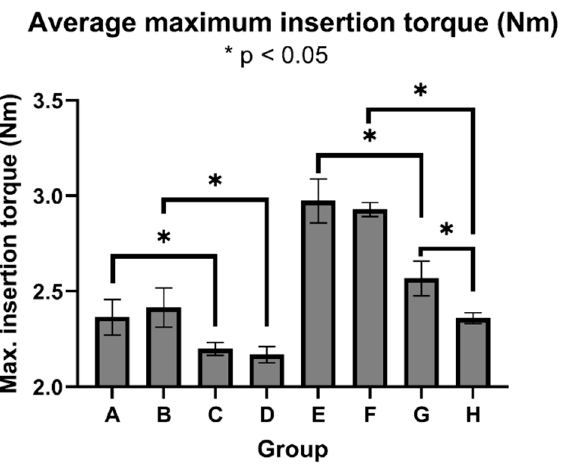
Figure 3. Bar chart of the mean insertion torque for each screw design. Error bars represent plus or minus one standard